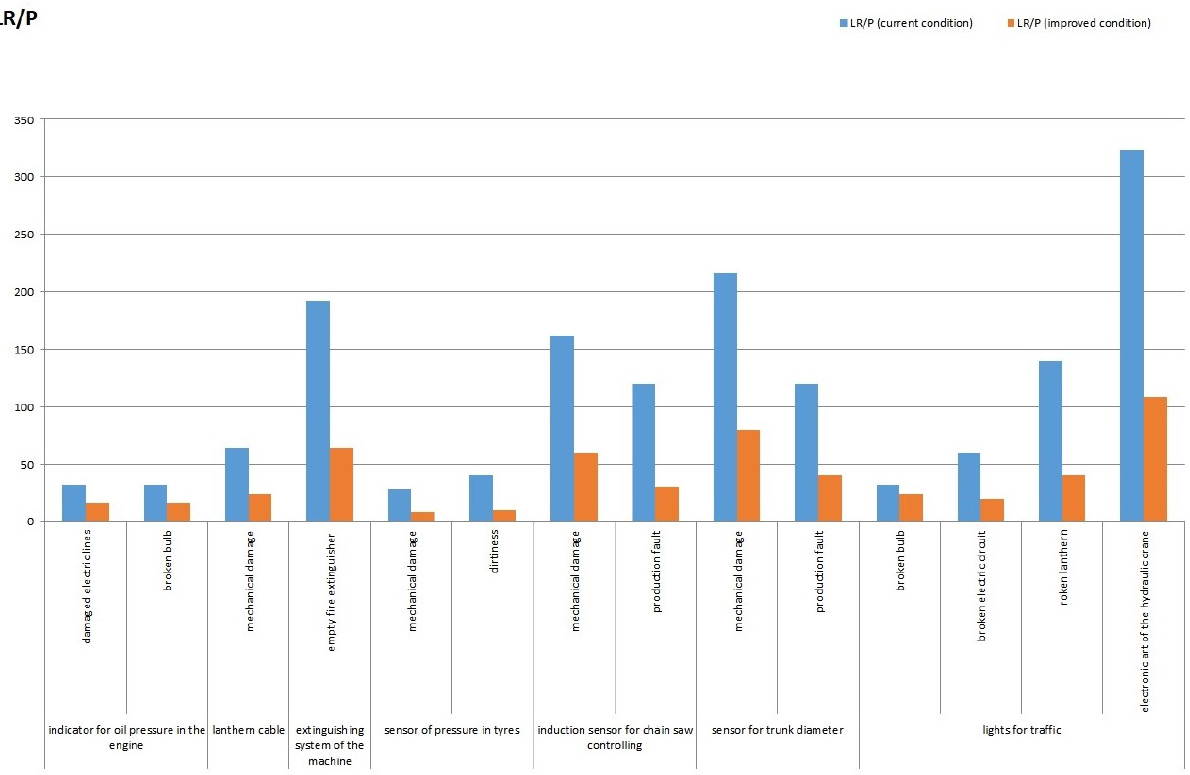
Figure 5: FMEA results for electric systems of the machine (sensors) of harvester John Deere 1070D